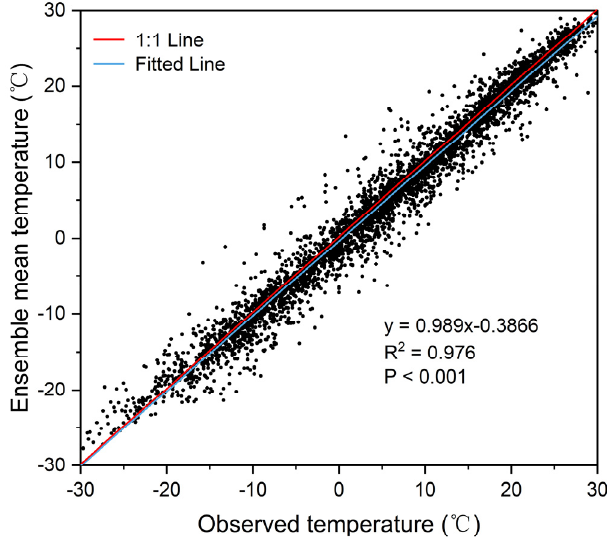
Figure 7. Validation of the ensemble mean temperature of the 12 CMIP6 models against the observed temperature. Each black dot represents a randomly selected grid point within China.